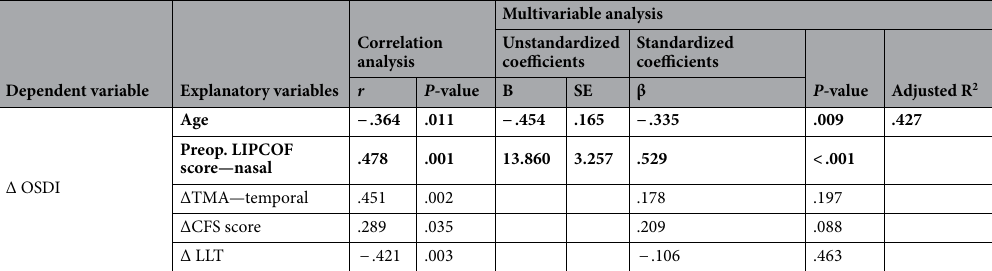
Table 3. Multivariable regression analysis evaluating the effect of clinical variables on symptomatic improvement in dry eye patients following conjunctivochalasis correction. Significant values are presented in bold type. Each P- value was obtained via Spearman correlation analysis or stepwise multivariable regression analysis; r , Spearman’s correlation coefficient; SE, standard error; Δ, difference between postoperative and preoperative values. OSDI, ocular surface disease index; LIPCOF, Lid-parallel conjunctival folds; TMA, tear meniscus cross-sectional area; CFS, corneal and conjunctival fluorescein staining based on Oxford schema; LLT, Lipid layer